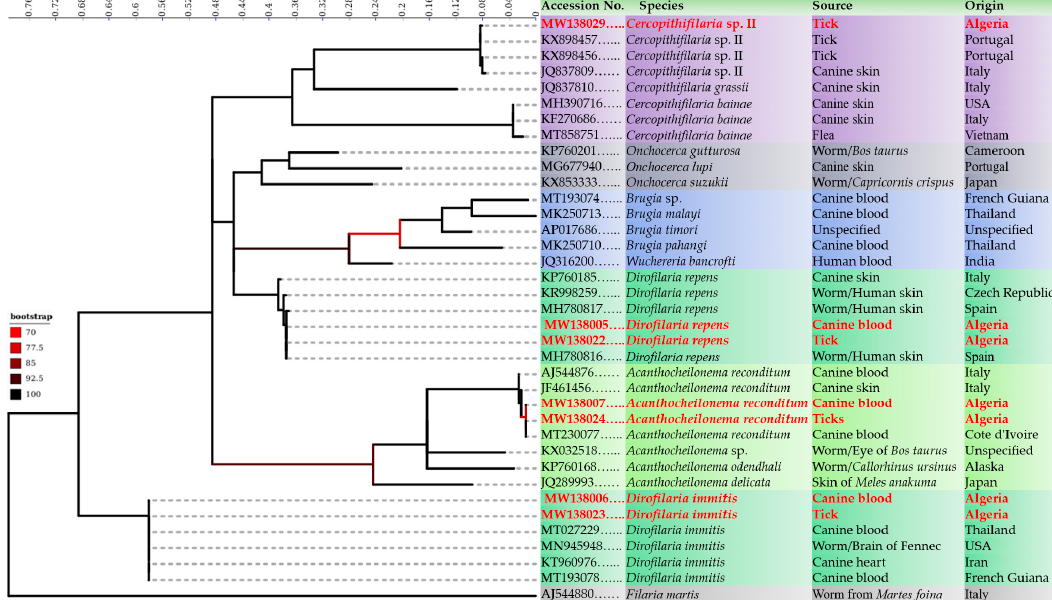
Figure 2. Phylogenetic tree showing the clusterization of filarial genotypes identified in the present study with the other filarioids. The tree was inferred using the Maximum Likelihood method based on 1000 bootstraps and the Tamura-Nei model. The analysis involved 36 partials (453 bp) cox 1 sequences of filarioids. Outgroup taxons Filaria martis (AJ544880) is drawn at root. A discrete Gamma distribution was used to model evolutionary rate differences among sites (5 categories (+G, parameter = 0.5779)). The rate variation model allowed for some sites to be evolutionarily invariable ([+I], 49.5935% sites). Log likelihood was-2738.5083. The axis showed the global distance observed throughout the trees. The identity of each taxa is color-coded according to the genus. Branches are color-coded according to the bootstraps